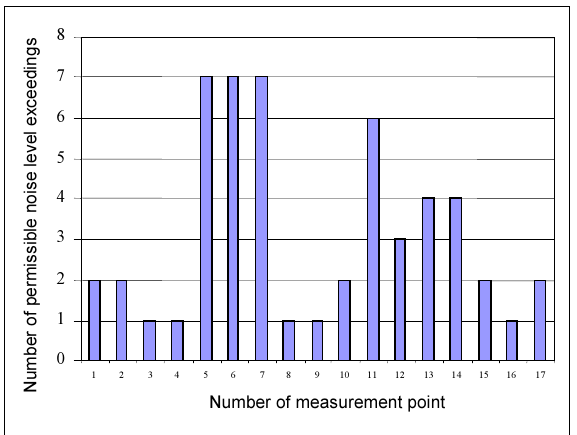
Fig. 4. Number of the excesses of permissible noise level at